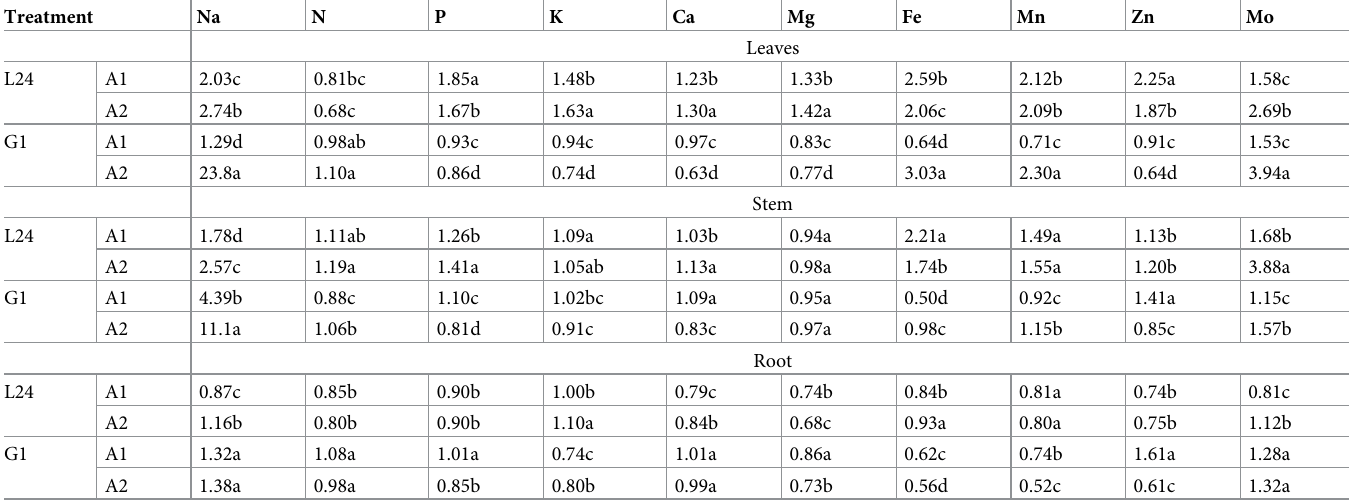
Table 4. The relative content of elements in leaves, stem and root of two cotton varieties under alkaline stress. Treatment